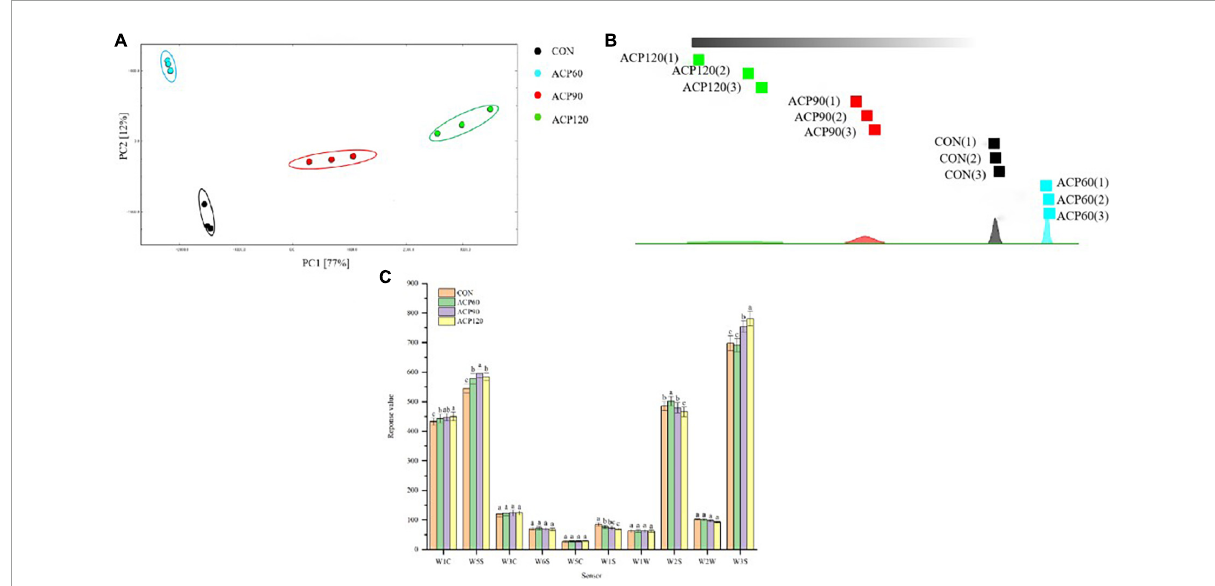
FIGURE4 The analysis of PCA (A) , nearest neighbor algorithm distance map (B) , and response value (C) by E-nose of surimi gels subjected to different treatment times. The different lowercase letters represent significant differences ( p < 0.05). (CON, surimi gels without ACP treatment; ACP60, surimi gels treated with ACP for 60 s; ACP90, surimi gels treated with ACP for 90 s; ACP120, surimi gels treated with ACP for 120 s).